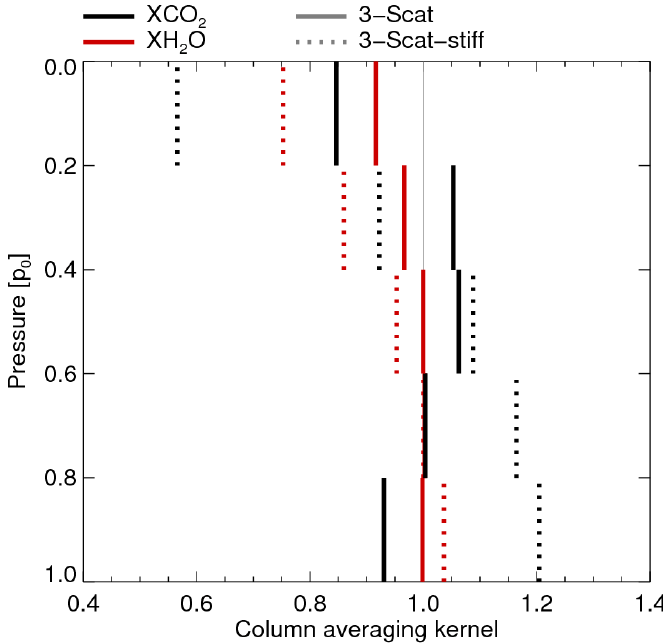
Figure 14. XCO 2 and XH 2 O column averaging kernels for the 3-Scat and 3-Scat-stiff retrieval setups and the geophysical Rayleigh scenario ( θ 0 = 40°, perpendicular polarization).